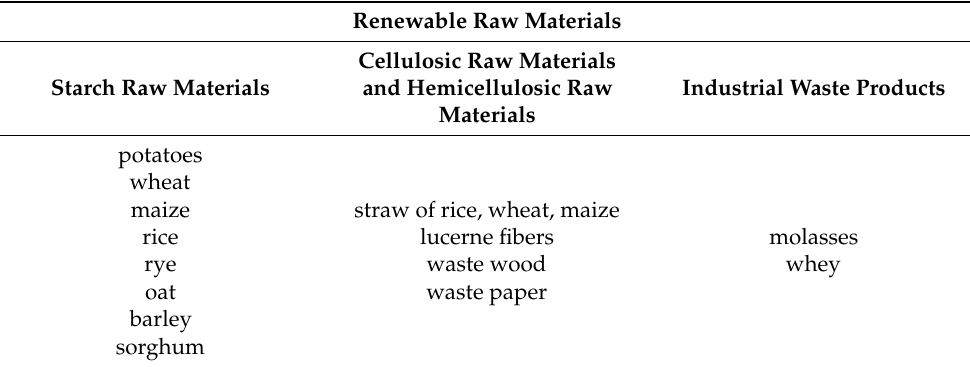
Table 3. Renewable raw materials used in the industrial production of lactic acid. Renewable Raw